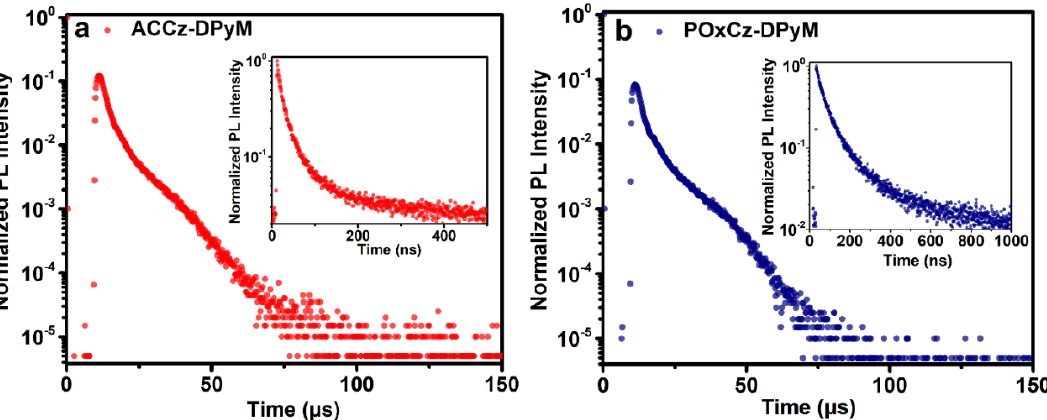
Figure 3. Transient spectra of ACCz−DPyM ( a ) and POxCz−DPyM ( b ) in doped films (8 wt% doped in mCBP) at 300 K. Inset: prompt fluorescence.